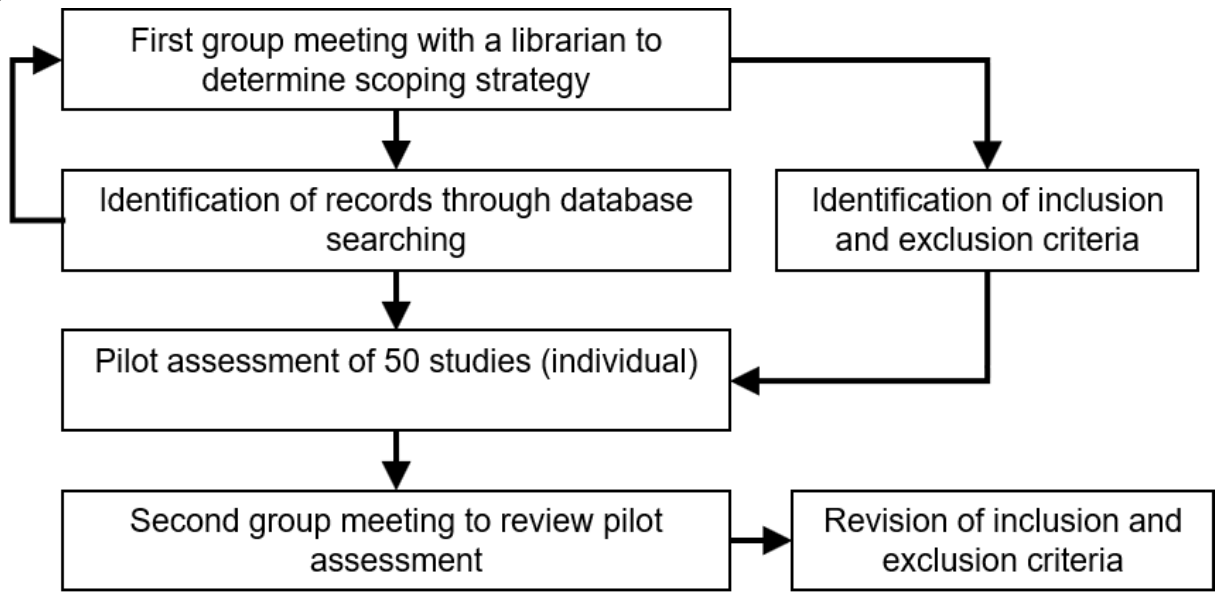
Figure 2. Pilot assessment and revision of criteria for selection of sources of